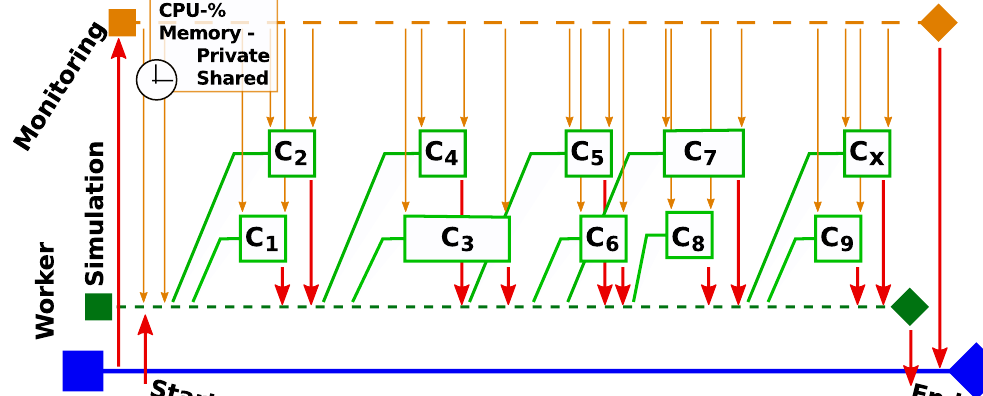
Figure 8. Scheme showing the sequence of events when a Maestro Worker (shown in blue) running a simulation thread that spawns multiple child threads is started. The simulation thread (in green) is initialized, after which the monitoring thread (in orange) is started. The simulation thread is then started and spawns child threads (C which is monitored individually by the monitoring thread (indicated by the orange arrows). The transfer of data between threads is indicated by the red